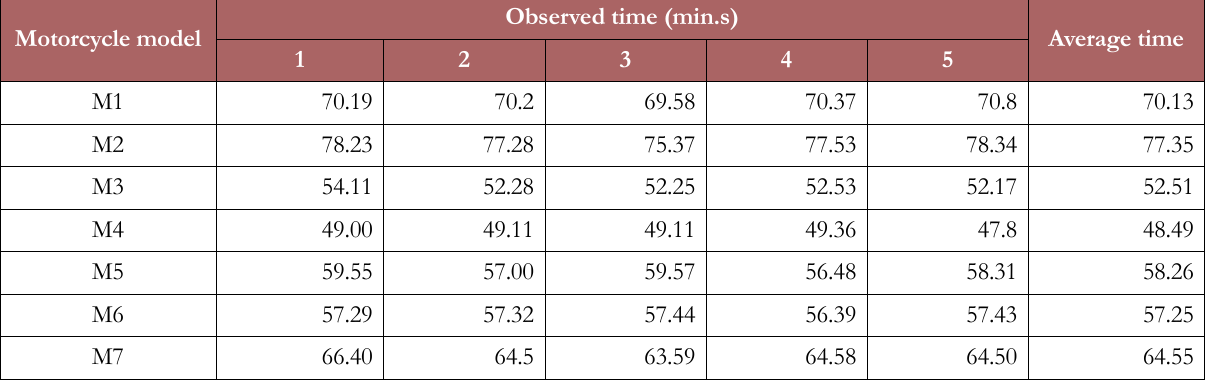
Table 4. Observed times for assembly rear of motorcycles, cell